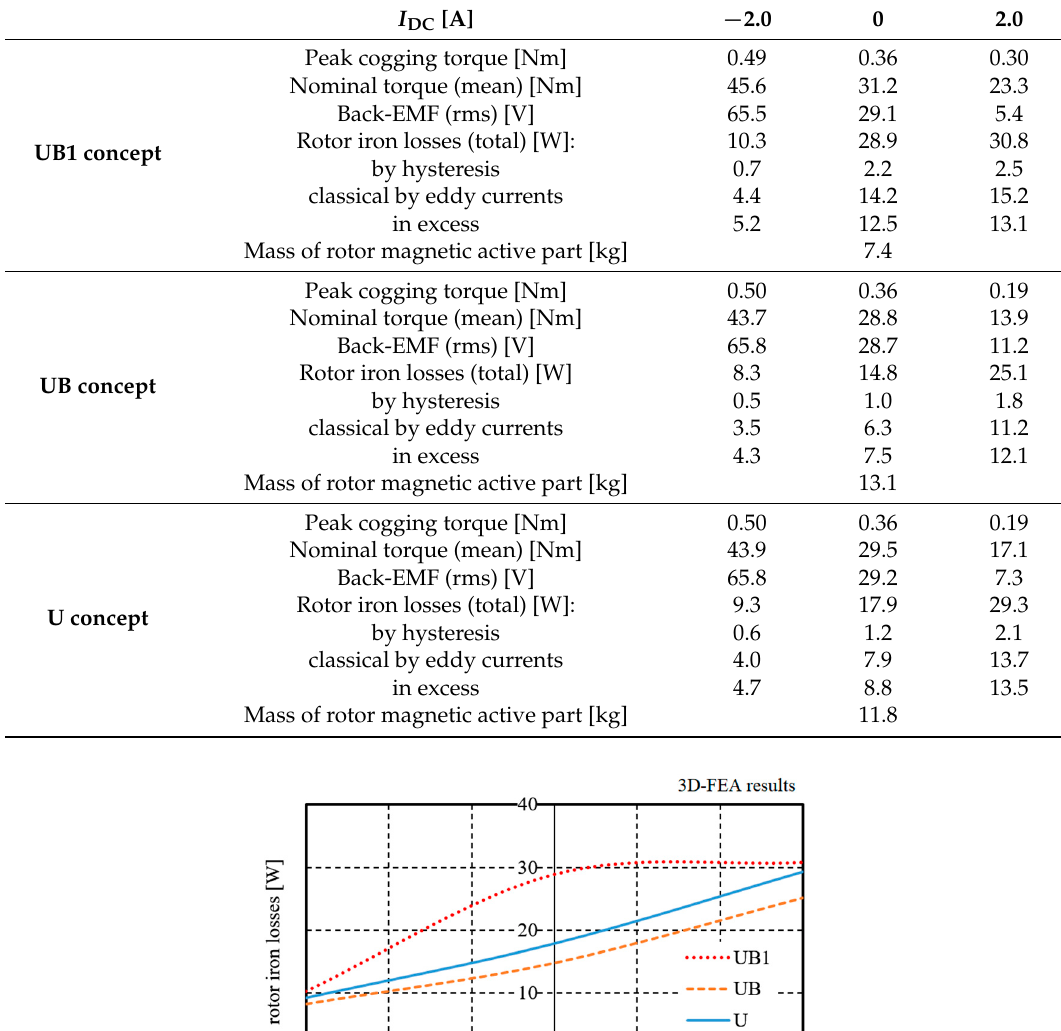
Table 3. 3D-FEA results of phase magnetic flux linkage.